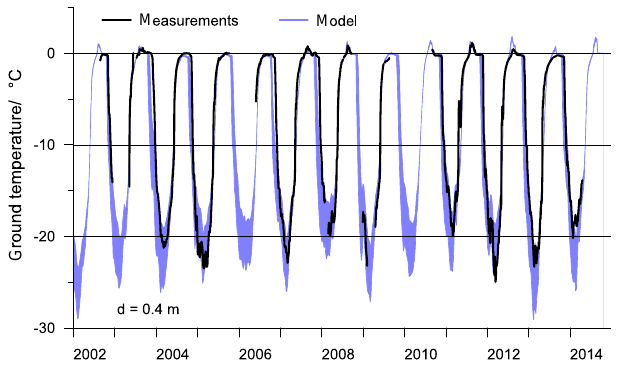
Figure 6. Modeled and measured ground temperatures at a depth of 0.4m at a wet polygon center on Samoylov Island (Boike et al., 2013). The blue area depicts the spread between model runs with snow densities of 200 and 250kgm − 3 . The temperature sensor drifted by about − 0.2 ◦ C (at 0 ◦ C) in the shown period.